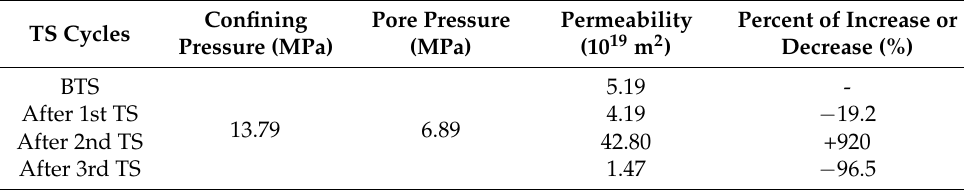
Table 6. Permeability results of core sample SH#5 before and after thermal